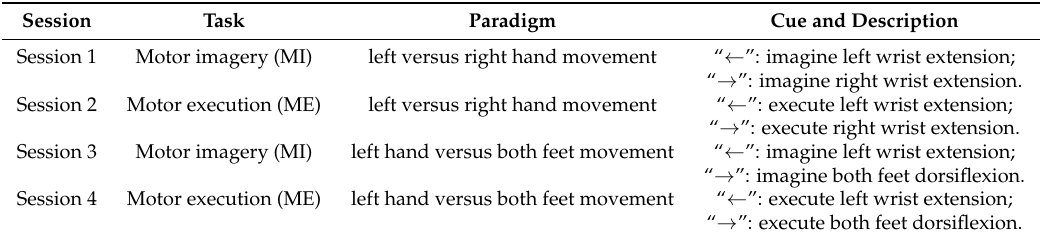
Figure 1. Experimental setup. ( a ) in the decoder-training phase, subjects were instructed to perform ME or MI under two paradigms, i.e., left versus right hand movement and left hand versus both feet movement. The left arrow indicated left wrist extension, and the right arrow indicated right wrist extension for Sessions 1 and 2 or both feet dorsiflexion for Sessions 3 and 4. ( b , c ) in the online-control phase, the trained decoder using the selected paradigm was tested in two scenarios with a visual feedback. In the first scenario, subjects without wearing the exoskeleton (it was hung up beside the subject) controlled it by using ME or MI; in the second scenario, subjects wearing the exoskeleton on the right arm controlled it by using ME or MI. Table 1. The descriptions of four sessions in the decoder-training